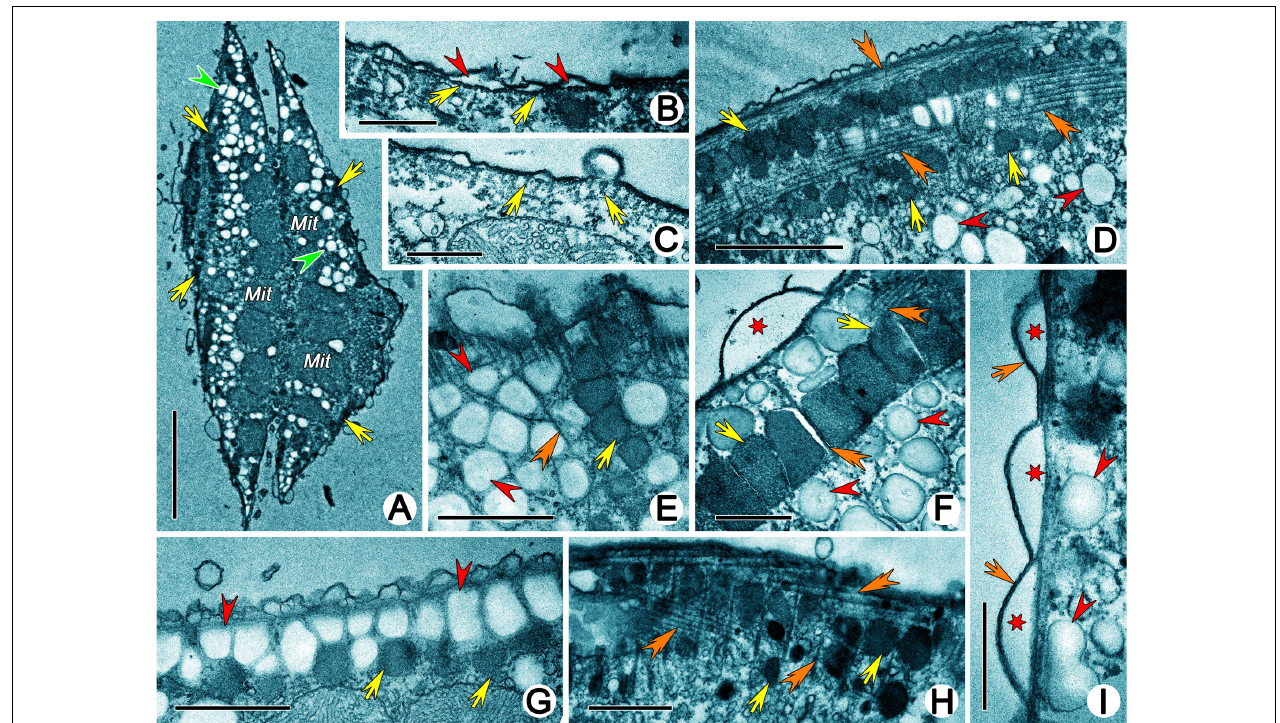
FIGURE 3 | Transmission electron micrographs of cortex of Uronychia binucleata . (A) Longitudinal section of cell near dorsal surface, showing the arrangement of extrusomes (arrows), vesicular structures (arrowheads) and mitochondria (Mit). (B,C) Subpellicular microtubules (arrows) arrange singularly in venter (B) and as triads in dorsum (C) . Arrowheads mark alveoli. (D) Subpellicular microtubules (double-arrowheads) and extrusomes (arrows) distribute at intervals, which might be the longitudinal section of cortical grooves occupied by dorsal kineties. Arrowheads point to vesicular structures. (E–G) Vesicular structures (arrowheads) and extrusomes (arrows) are restricted by numerous microtubules (double-arrowheads) and showed as rectangle-like. Asterisk indicates alveolus. (H) Extrusomes (arrows) distribute among microtubules (double-arrowheads). (I) Cortex region, showing plasmalemma (arrows), alveoli (asterisks) and vesicular structures (arrowheads). Mit, mitochondria. Scale bars = 5 µ m (A) , 0.5 µ m (B,C,F,I) , 2 µ m (D) , 1 µ m (E,G,H)